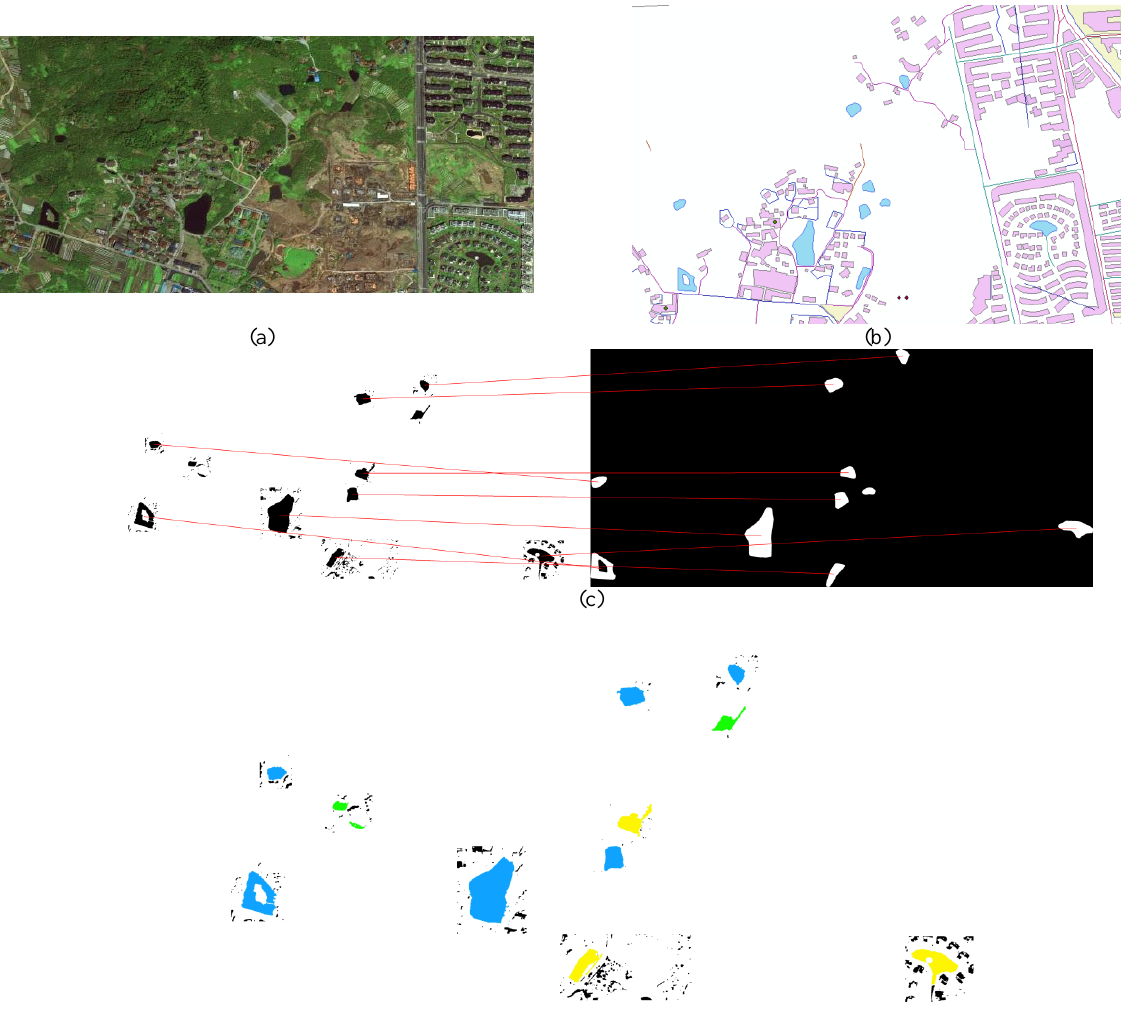
Figure.3 Registration and water-body extraction result of data set A. (a) optical image. (b) 1:10000 GIS data over the same area of image. (blue objects represent data of water layer) (c) Registration results (left is initial extraction results; right is GIS data of water- bodies; red lines represent matching relations). (d) final water extraction result (blue objects represent unchanged water-bodies, yellow objects represent changed ones and green objects represent newly added water-bodies)